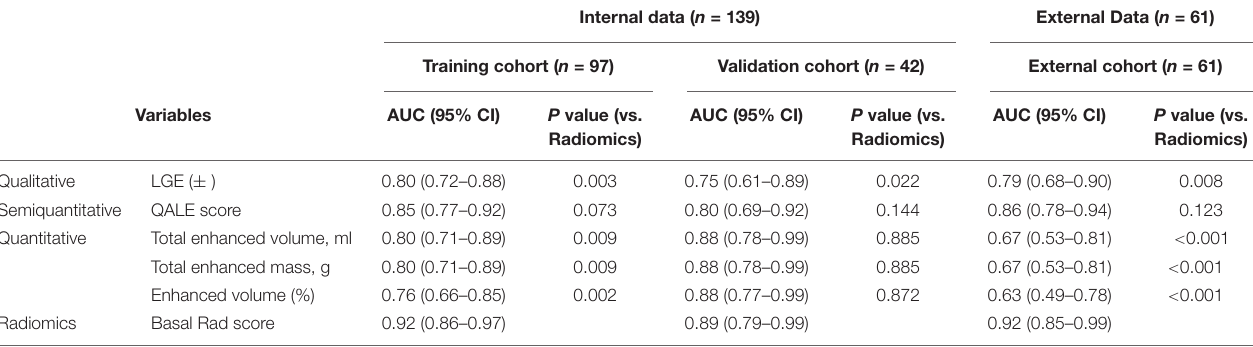
FIGURE 5 | Receiver operating characteristic (ROC) curves analysis for comparison of diagnostic performance of radiomics with qualitative and quantitative LGE assessment. Basal radiomics vs. qualitative (LGE pattern), semiquantitative (QALE score), and quantitative (based on cardiac magnetic resonance (CMR) software) assessment parameters in the training (A) , internal (B) , and external validation (C) cohorts. QALE, query amyloid late enhancement. TABLE 3 | Diagnostic performance of qualitative, semiquantitative, and quantitative parameters in cardiac amyloidosis